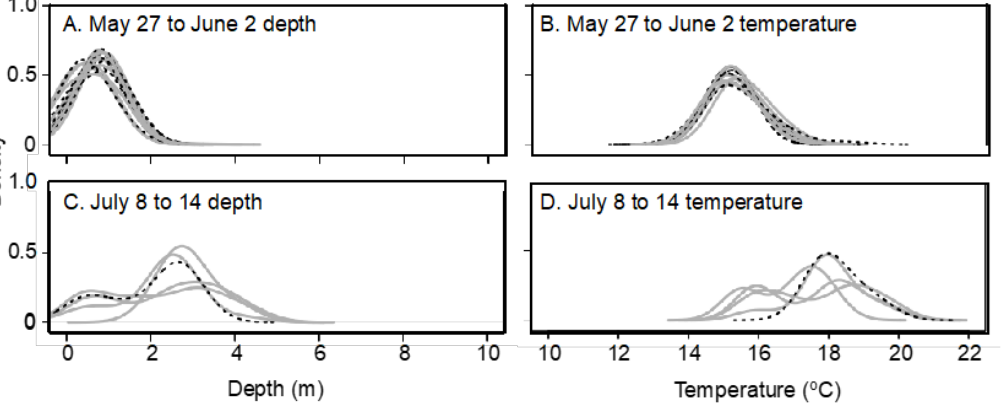
Figure 3. Kernel density plots of telemetry (Vemco VP TP transmitters) water depths ( A , C ) and temperature ( B , D ) logs for Blackwater rainbow trout ( Oncorhynchus mykiss ) in Pete’s Pothole 2 in 2008. Gray lines represent diploid (2N) trout and dotted black lines represent triploid (3N) trout from 27 May to 1 June ( A , B ) and 8 to 14 July ( C , D ). From 27 May to 2 June, n was 11 for 2N and 7 for 3N. From 8 to 14 July, n was 4 for 2N and 1 for 3N.